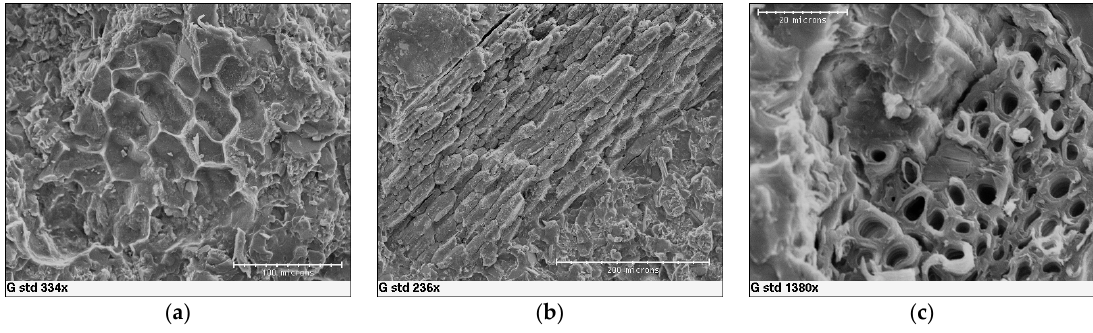
Figure 9. ( a – c ) SEM micrographs showing the interaction of almond ground shells within the PMMA-ATH matrix.